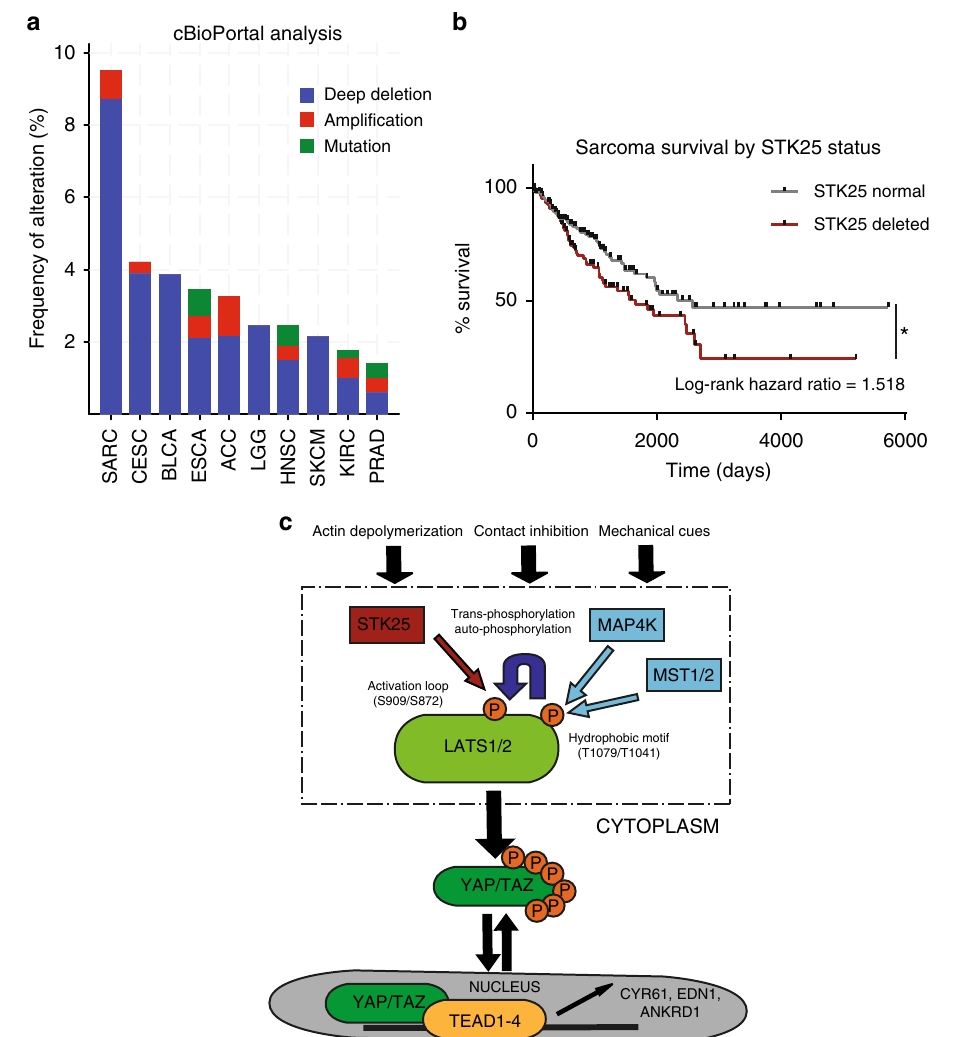
Fig. 7 STK25 loss is common in human cancers and adversely affects patient survival. a Graphical representation of human cancers with the highest frequencies of STK25 deletion. Data was accessed using the cBioPortal online program (http://www.cbioportal.org/). b Survival data of sarcoma patients from the TCGA dataset were accessed using the Xenabrowser online program (https://xenabrowser.net/) and overall survival rates and times were assessed for patients with and without deletions of STK25 (* p = 0.0172, n = 215, log-rank test). c Proposed model of STK25 in Hippo tumor suppressor